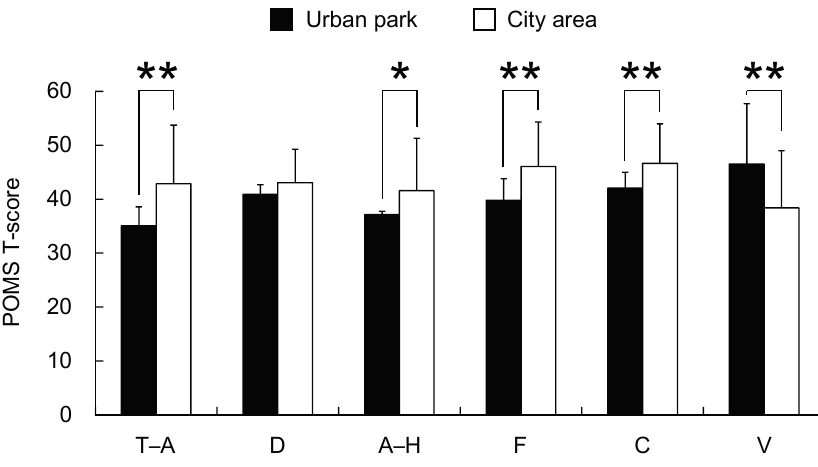
Figure 7. Comparison of subjective Profile of Mood State (POMS) scores between the two environments. T–A, tension–anxiety; D, depression–dejection; A–H, anger–hostility; F, fatigue; C, confusion; V, vigor. N = 23, mean ± standard deviation. * p < 0.05, ** p < 0.01, determined by the Wilcoxon signed-rank test